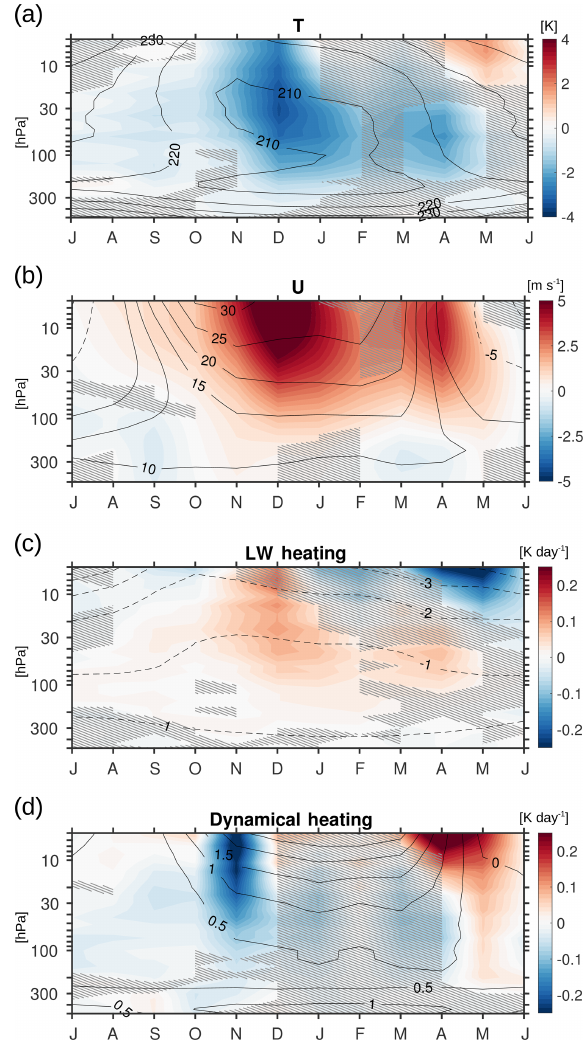
Figure 4. Climatological NH (a) polar cap (70 to 90 ◦ N) tempera- ture in K, (b) zonal mean zonal wind (55 to 75 ◦ N) in ms − 1 , (c) po- lar cap longwave heating rates in Kday − 1 , and (d) polar cap dy- namical heating rates in Kday − 1 with month and height for Chem OFF (contours) and for the differences between Chem ON and Chem OFF (shading). Contour intervals are (a) 10K, (b) 5ms − 1 , (c) 1Kday − 1 , and (d) 0.5Kday − 1 . Solid contours are used for pos- itive values, and dashed contours are used for negative values. The zero contour is omitted. Statistically insignificant areas are hatched at the 95%